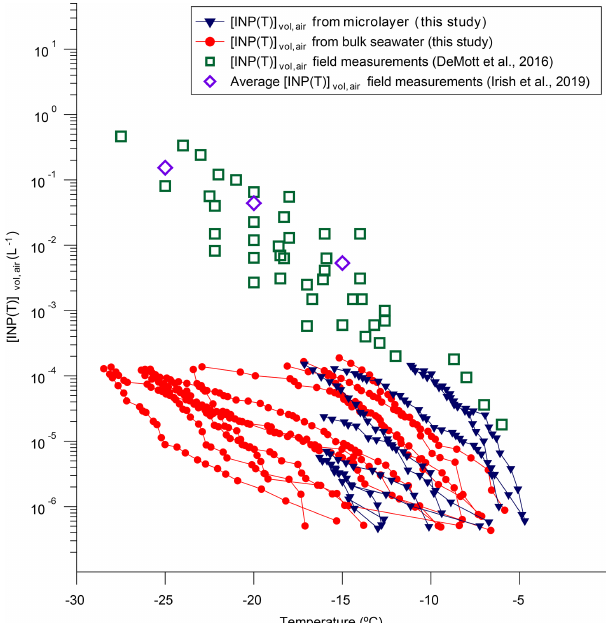
Figure 8. Plot of calculated [INP( T )] vol , air as a function of tem- perature based on our freezing data and an assumed sea salt aerosol concentration of 1µgm − 3 . Also included are measured [INP( T )] vol , air from several recent field campaigns in the ma- rine boundary layer reported in DeMott et al. (2016) and Irish et al. (2019). Only freezing data that were at warmer temperatures than the field blanks are